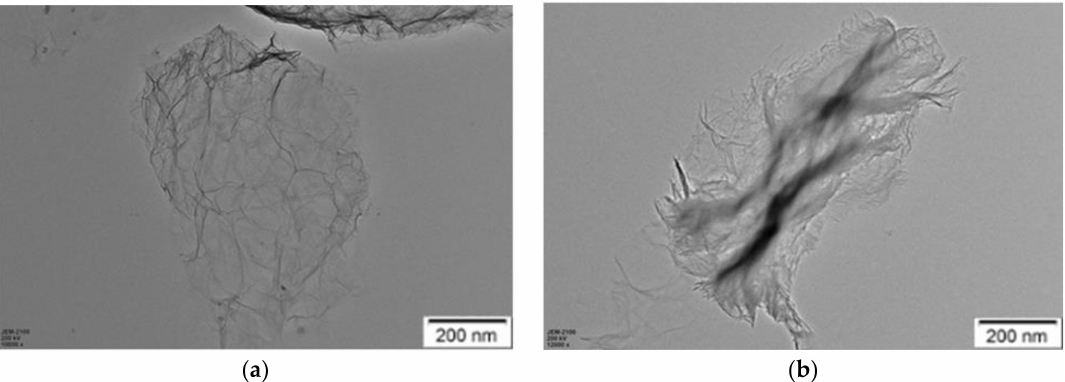
Figure 8. Scanning electron microscopy images of graphene: ( a ) before and ( b ) after the friction tests.